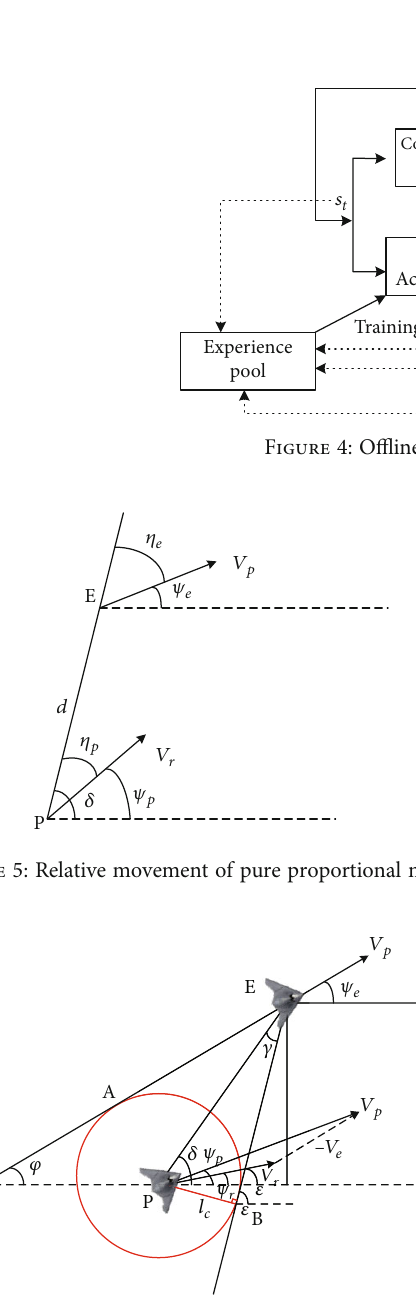
Figure 6: Diagram of quasiproportional guidance control law.